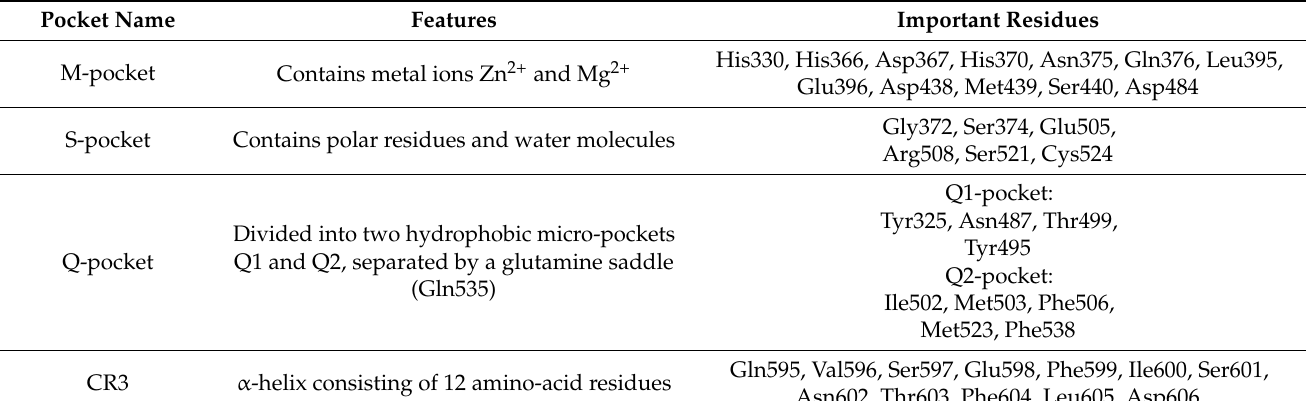
Table 1. The important residues of M, S, and Q pockets of the catalytic domain, together with the CR3 sequence of